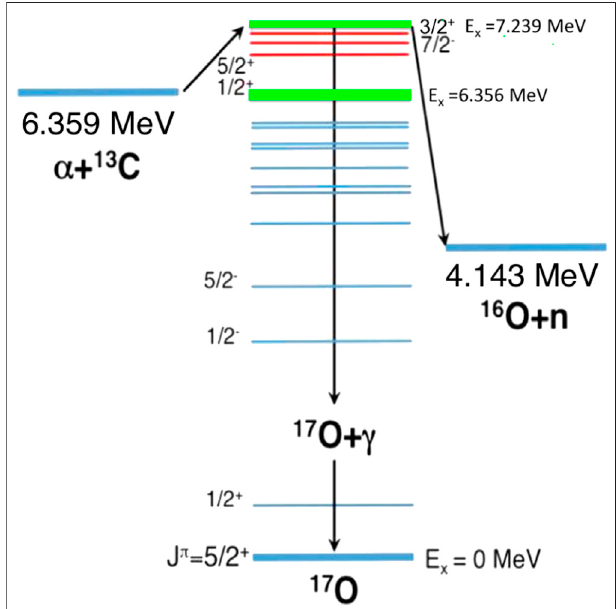
FIGURE 4 | (Colour online) Schematic diagram adapted from Cristallo et al. (2018) of the 13 C( α ,n) 16 O nuclear reaction process, together with the competing exit channel 17 O+ c . The excited states of interest for AGB nucleosynthesis are highlighted in